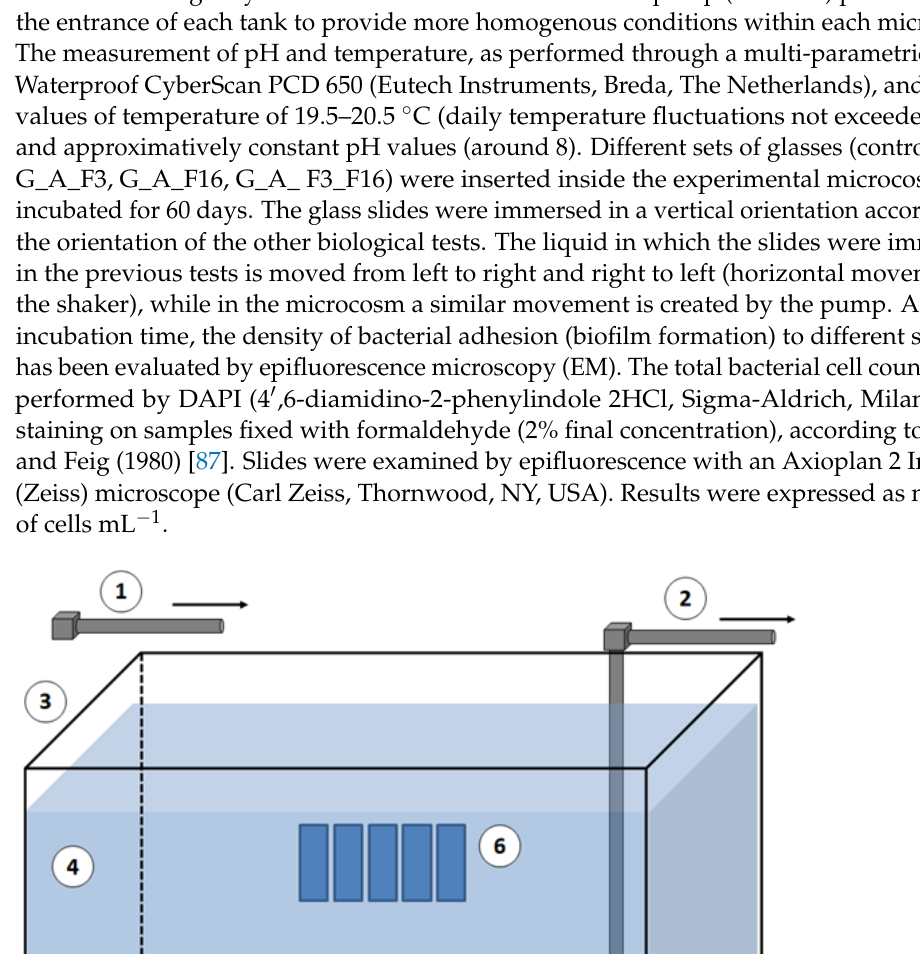
Figure 25. Schematic representation of the microcosm used in the study. Legend: ( (cid:192) ) inlet seawater system, ( ➁ ) outlet “too full” seawater system; ( ➂ ) experimental tank, ( ➃ ) seawater, ( ➄ ) internal pump, and ( ➅ ) experimental glass.